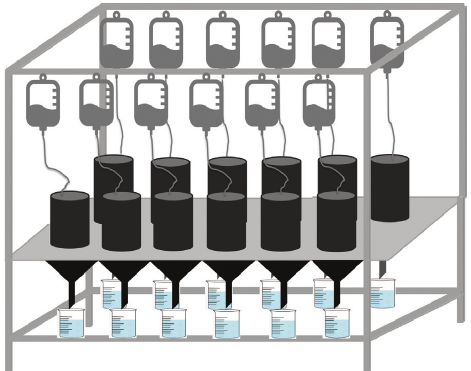
Figure 2: Leaching device of simulating N